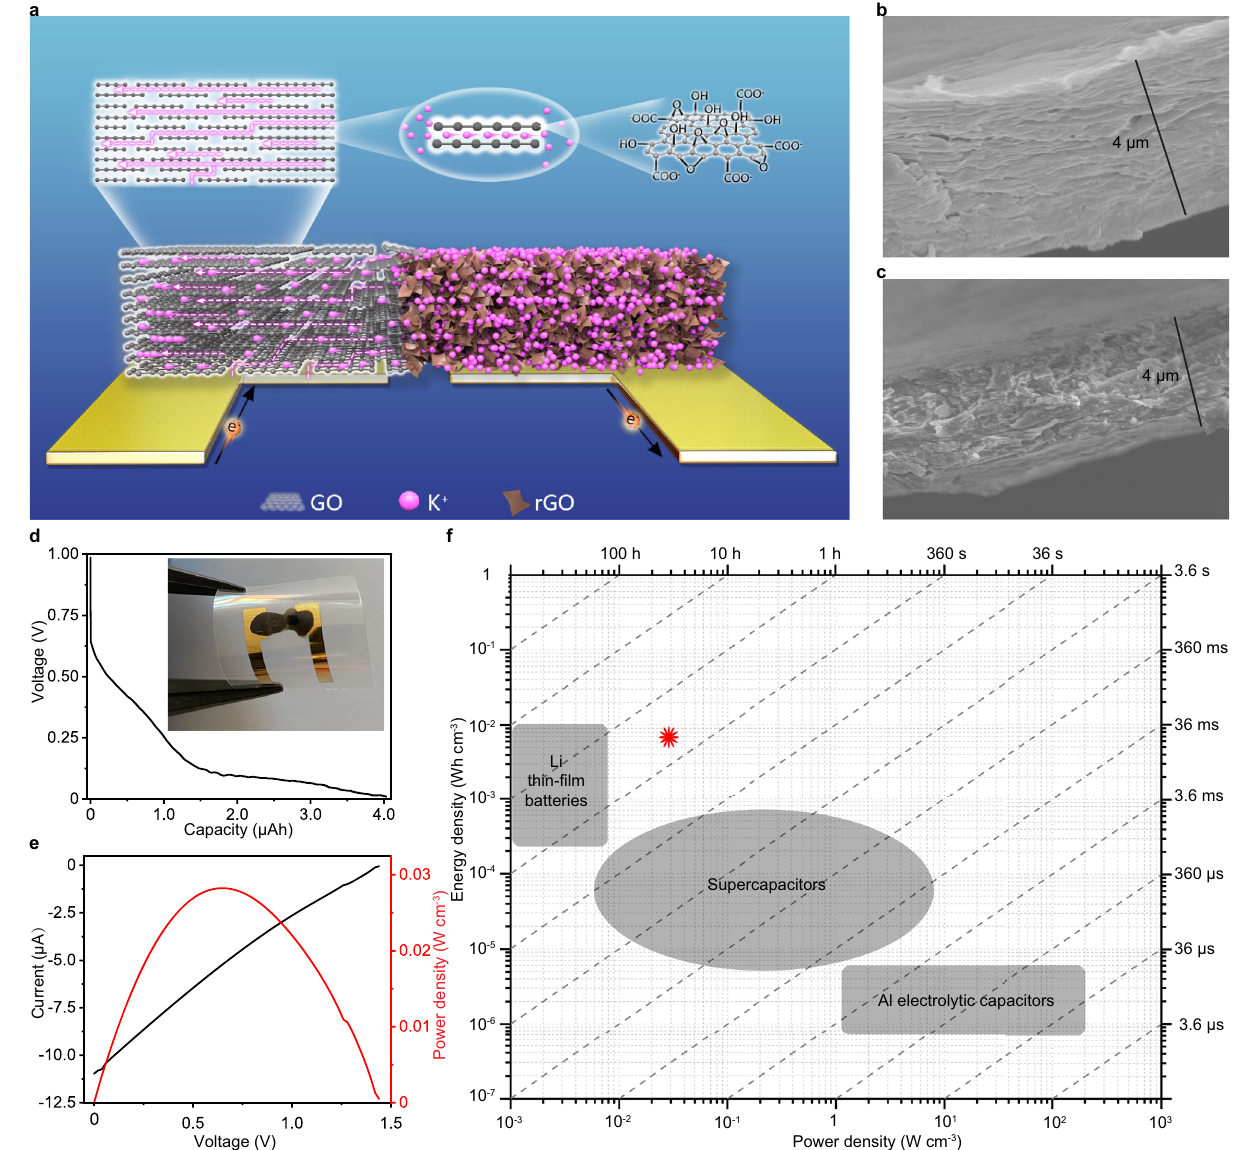
Fig. 1 | The planar osmotic power source. a Schematic illustration of GO/rGO junction and its mechanismofK + conduction in 2D nano fl uidicchannelswithinthe planar osmotic power source. b SEM image of the GO layer (cross section). c SEM image of the rGO layer (cross section). d Galvanostatic discharge performance of Au/AgNO 3 /GO/RTIL/rGO/Au at 0.1 μ A. Inset picture shows the photograph of the